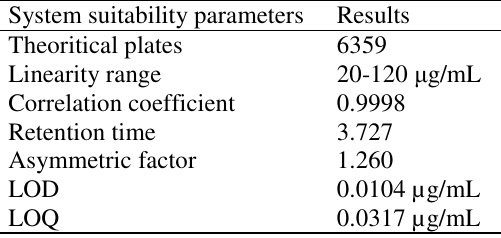
Table 3. Validation